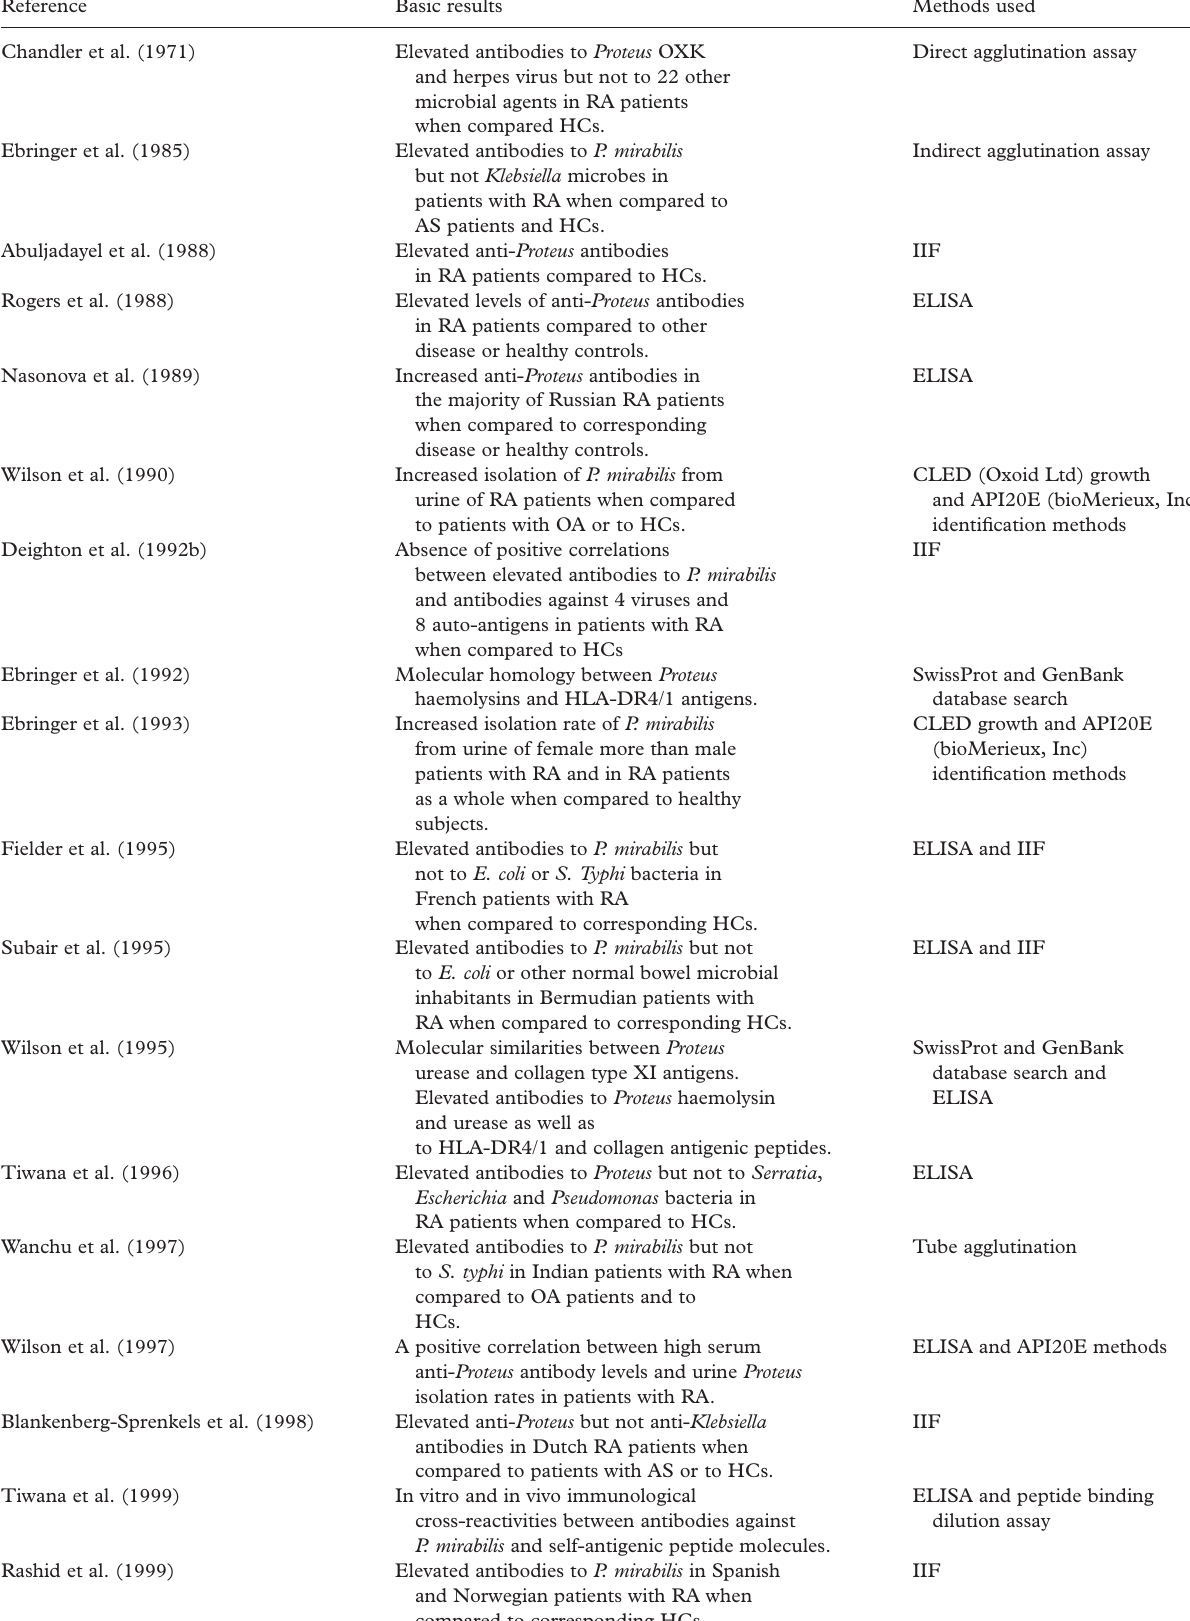
Table I. Chronologically listed evidence of microbiological, molecular and immunological links between Proteus microbes and rheumatoid arthritis